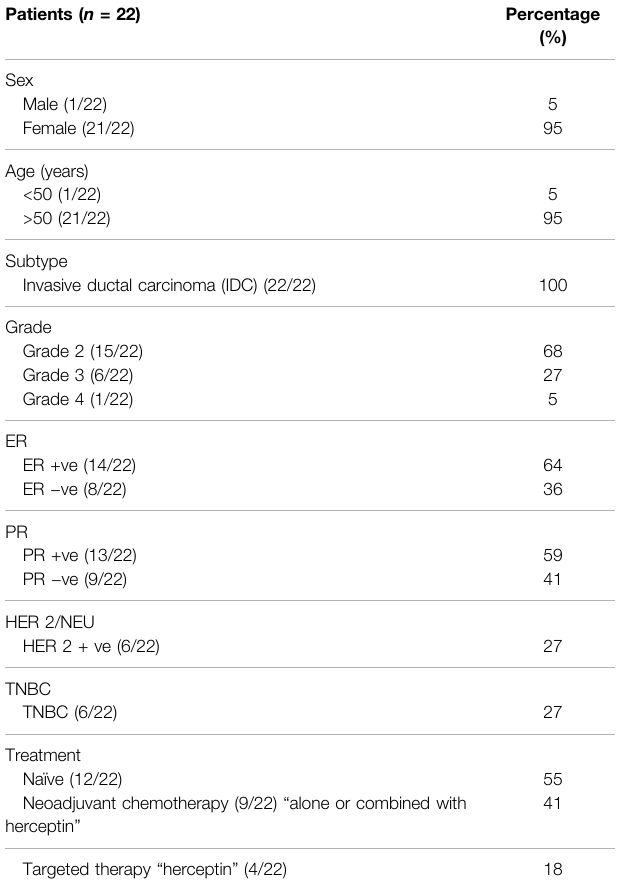
TABLE 1 | Patient